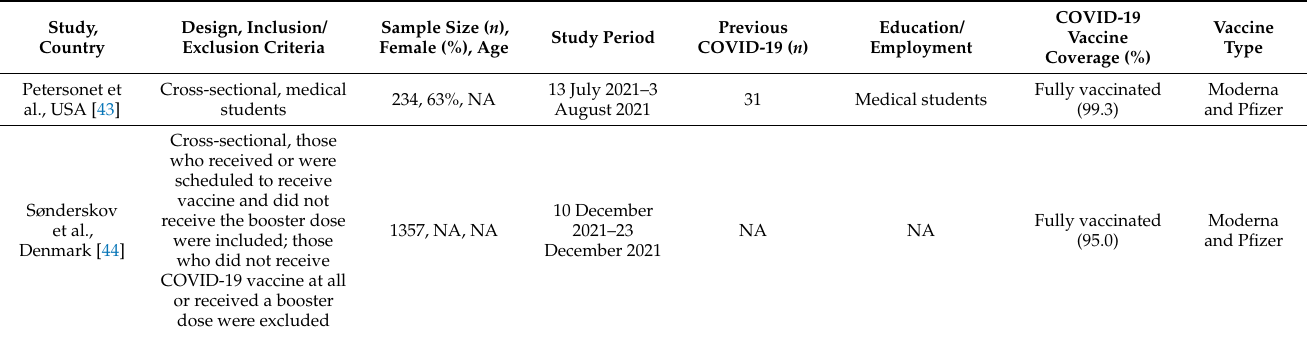
Table 1. Characteristics of studies included in the systematic